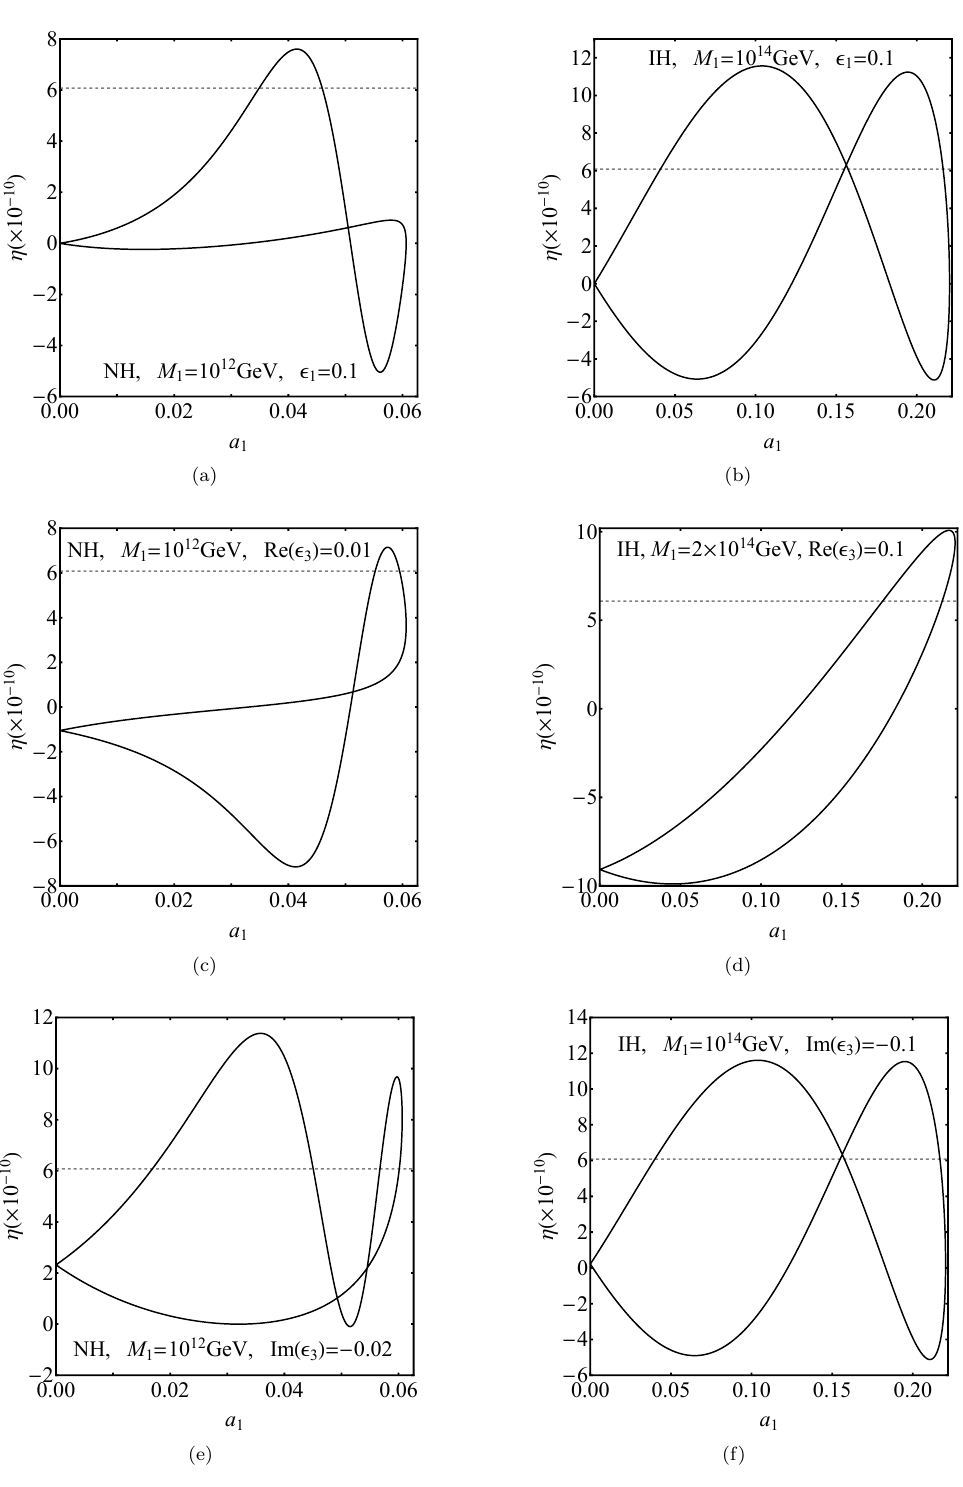
Figure 4 . The (cid:17) (as functions of a breaking parameters for the situation of M observed value of (cid:17)